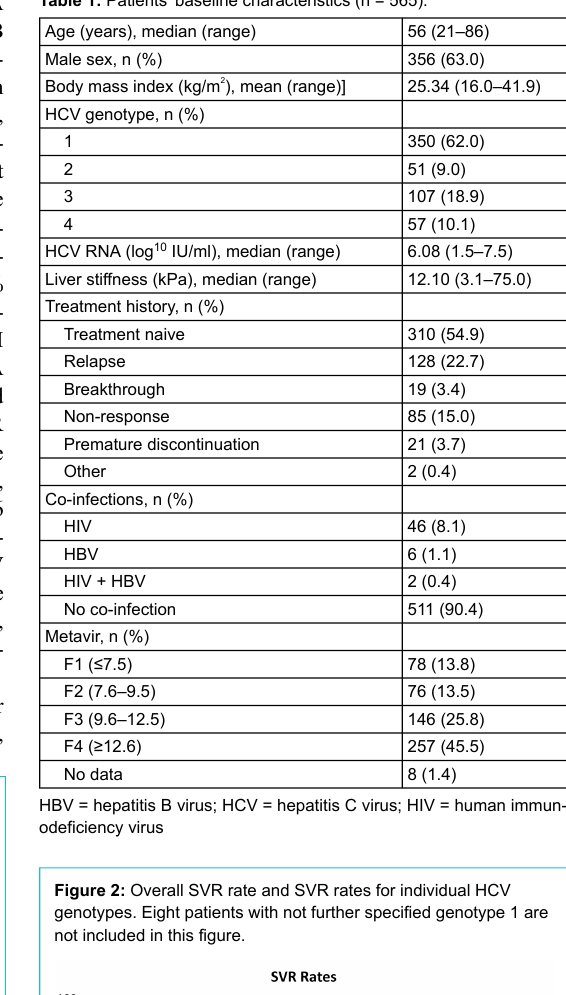
Table 1: Patients' baseline characteristics (n = 565).